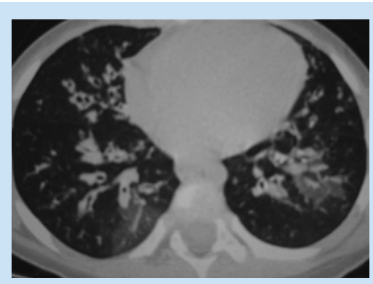
Fig.17c. Brochiolitis obliterans.